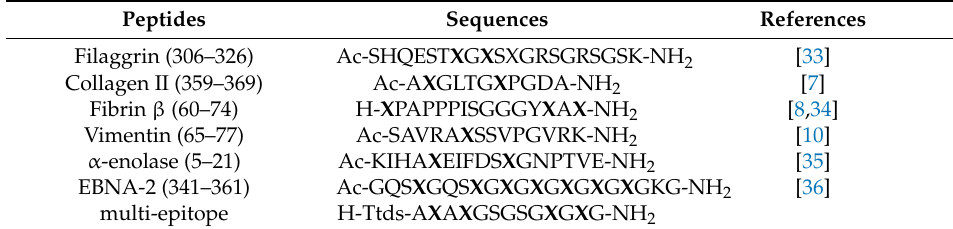
Table 1. List of citrulline containing peptides used in the assays.